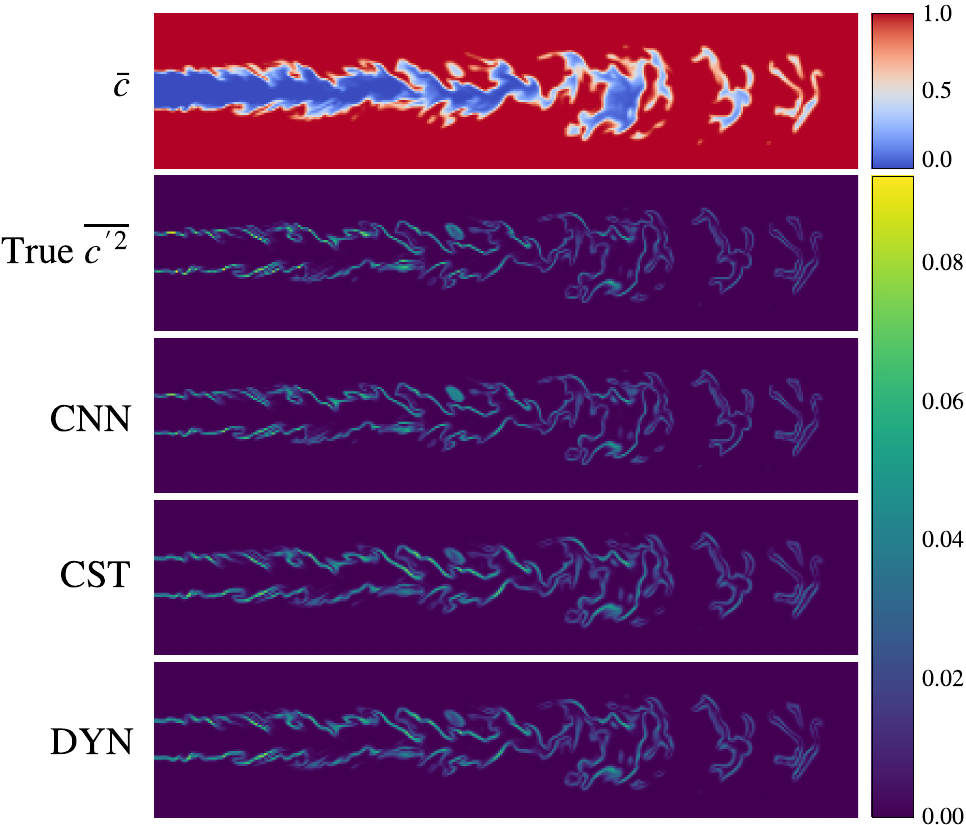
Figure 8. Sample R2 slices of c , true c (cid:48) 2 , CNN, CST, and DYN model predictions.